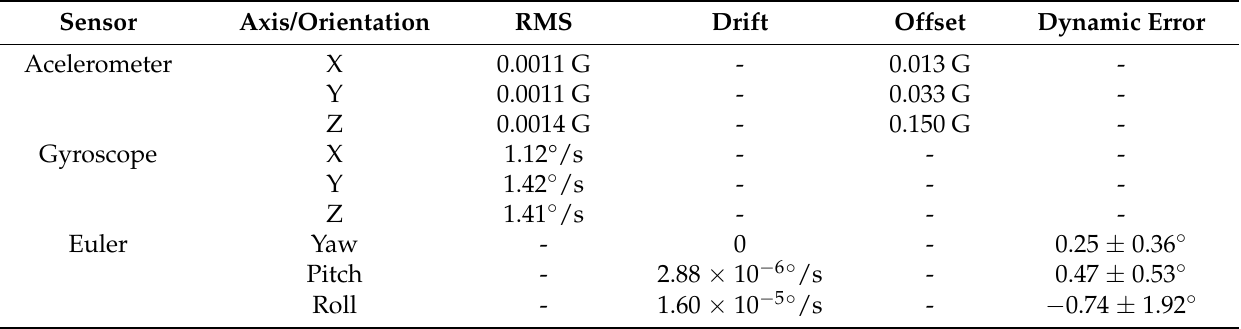
Table 1. Results for the static and dynamic evaluation of the sensor. Static evaluations where performed over 140 min of continuous